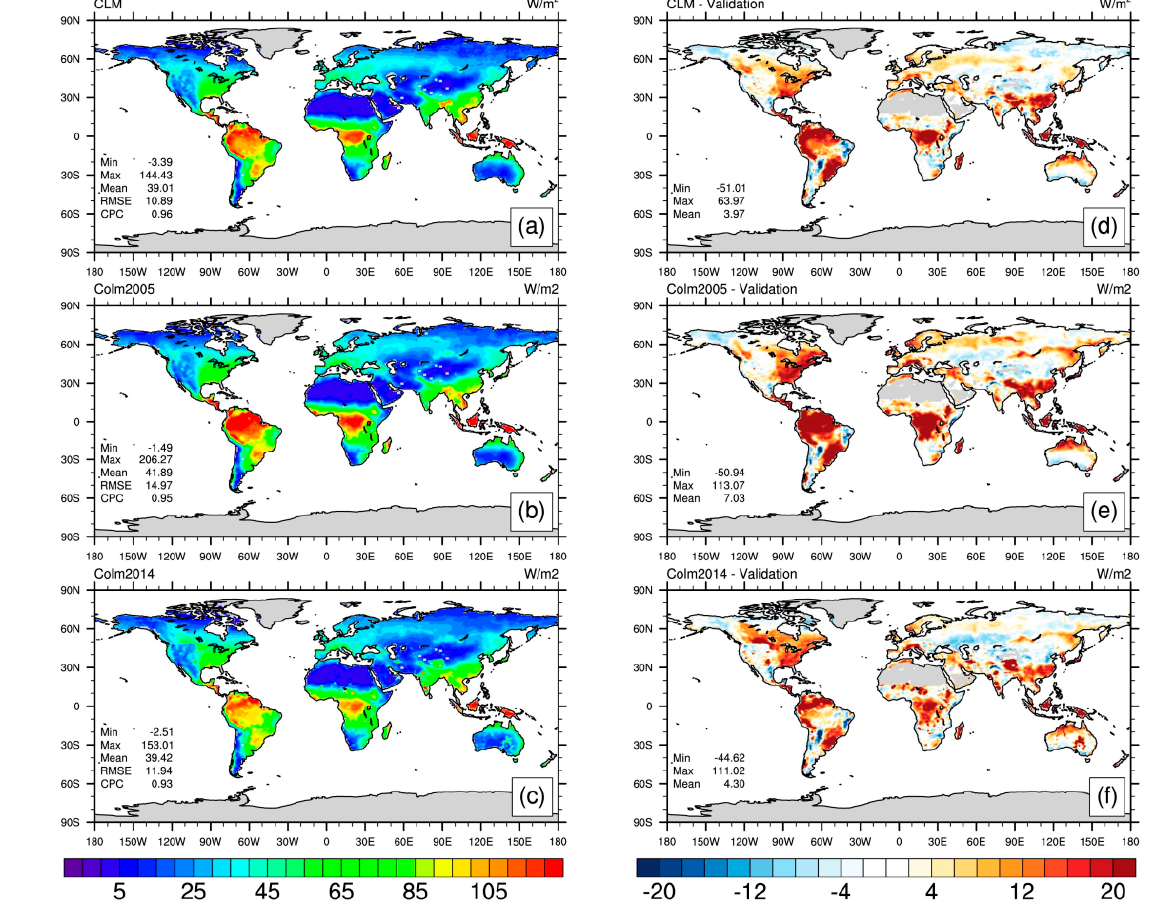
Figure 9. Annual mean spatial distributions of latent heat flux simulated by ( a ) CLM4.5; ( b ) CoLM2005; and ( c ) CoLM2014; Along with spatial distributions of biases relative to the validation standard for ( d ) CLM4.5; ( e ) CoLM2005; and ( f ) CoLM2014 (Units: W m − 2 ).